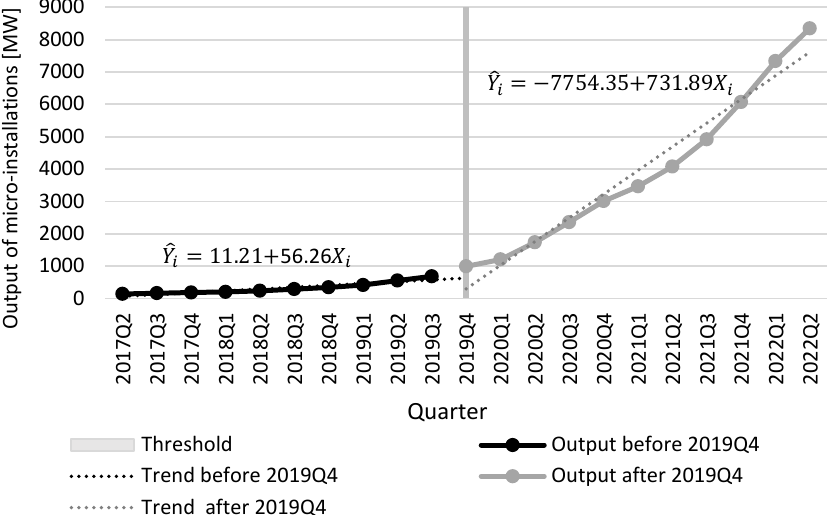
Figure 4. The regression discontinuity design models for the output of micro-installations in Poland.